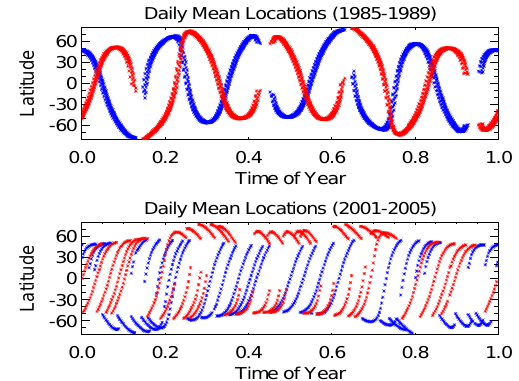
Figure 11. Locations of daily means for each satellite event type (sunrises are blue and sunsets are red) at the beginning and end of the mission.